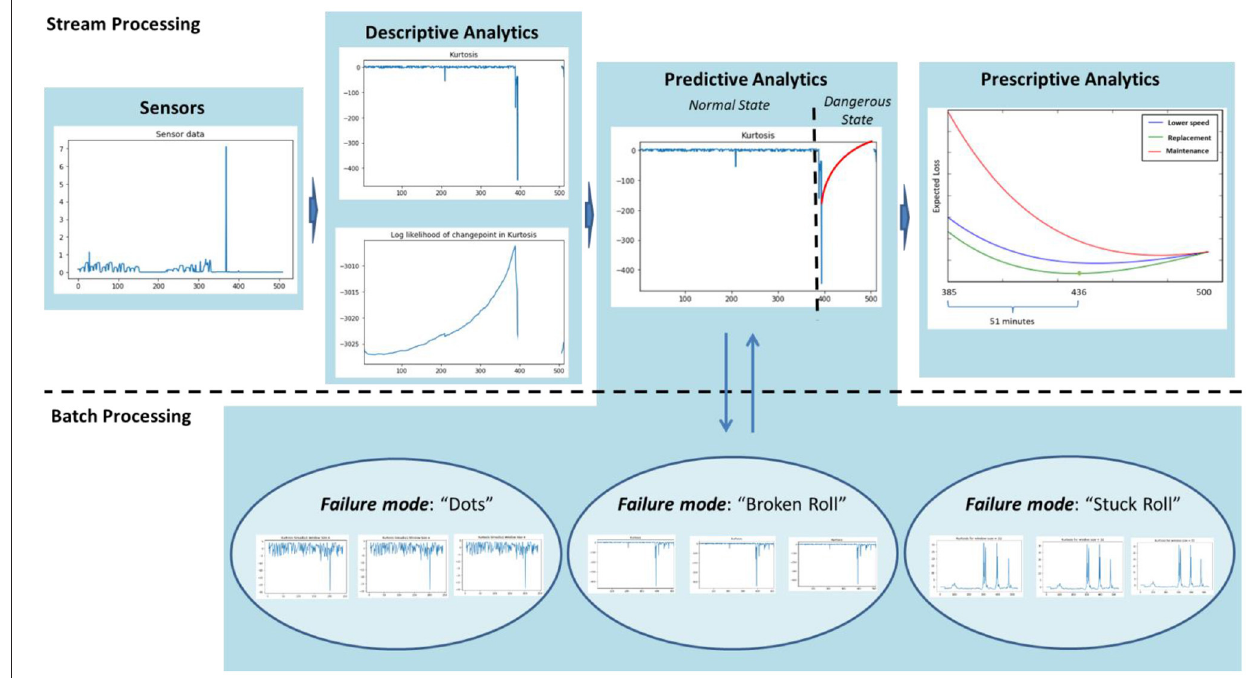
FIGURE 7 | An illustrative scenario in the context of the case study.